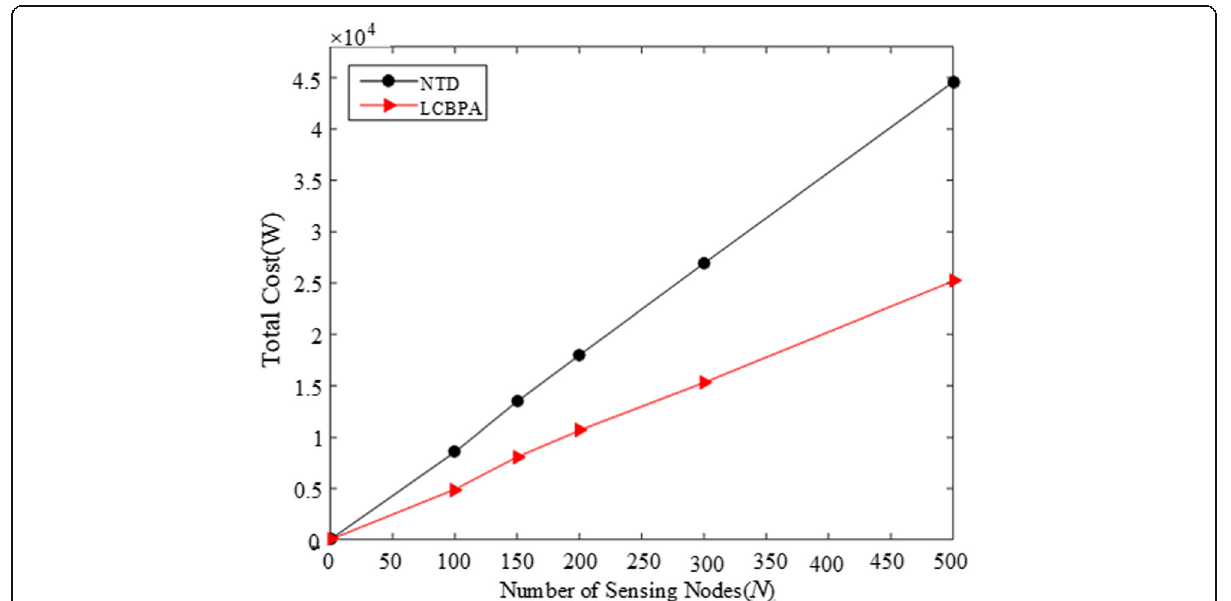
Fig. 5 Total cost comparison of LCBPA and NTD when k = 20, α = 0.5 under different network scale